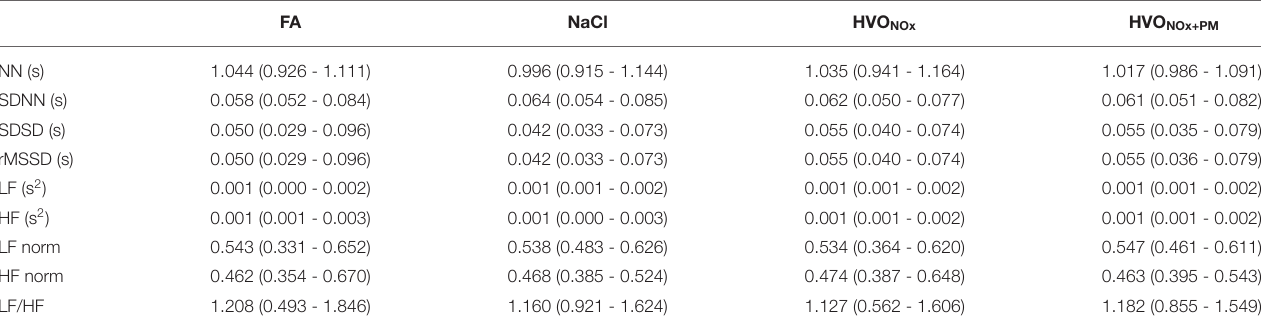
TABLE 3 | Median and interquartile range (Q 1 -Q 3 ) of pre-exposure HRV features for each exposure